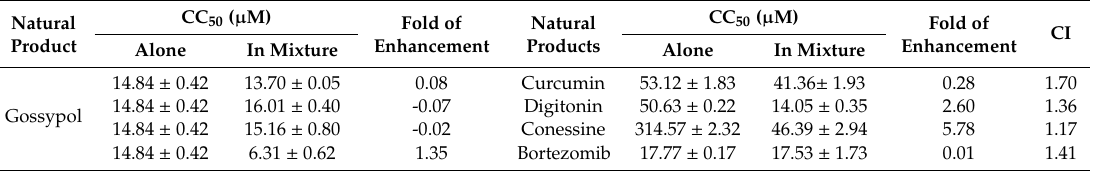
Natural Enhancement Products